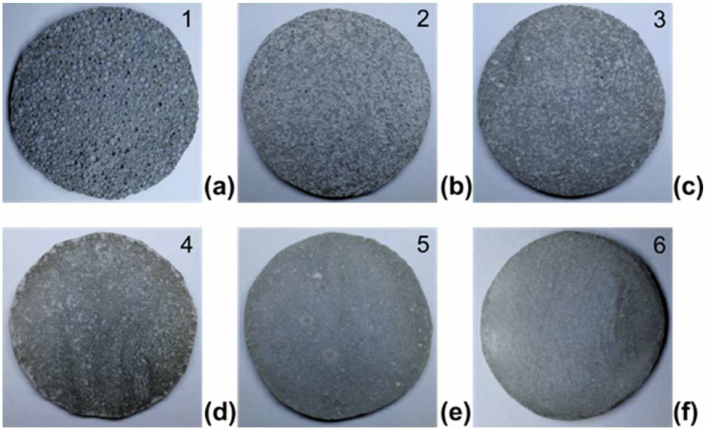
Figure 2. Optimisation of samples from mould casting with gradual improvement in compaction: ( a ) very poor, ( b ) poor, ( c ) acceptable, ( d ) good, ( e ) very good and ( f ) excellent. (Note: the lowest sample number ‘1’ indicates a poor homogeneity, and the highest sample number ‘6’ indicates excellent